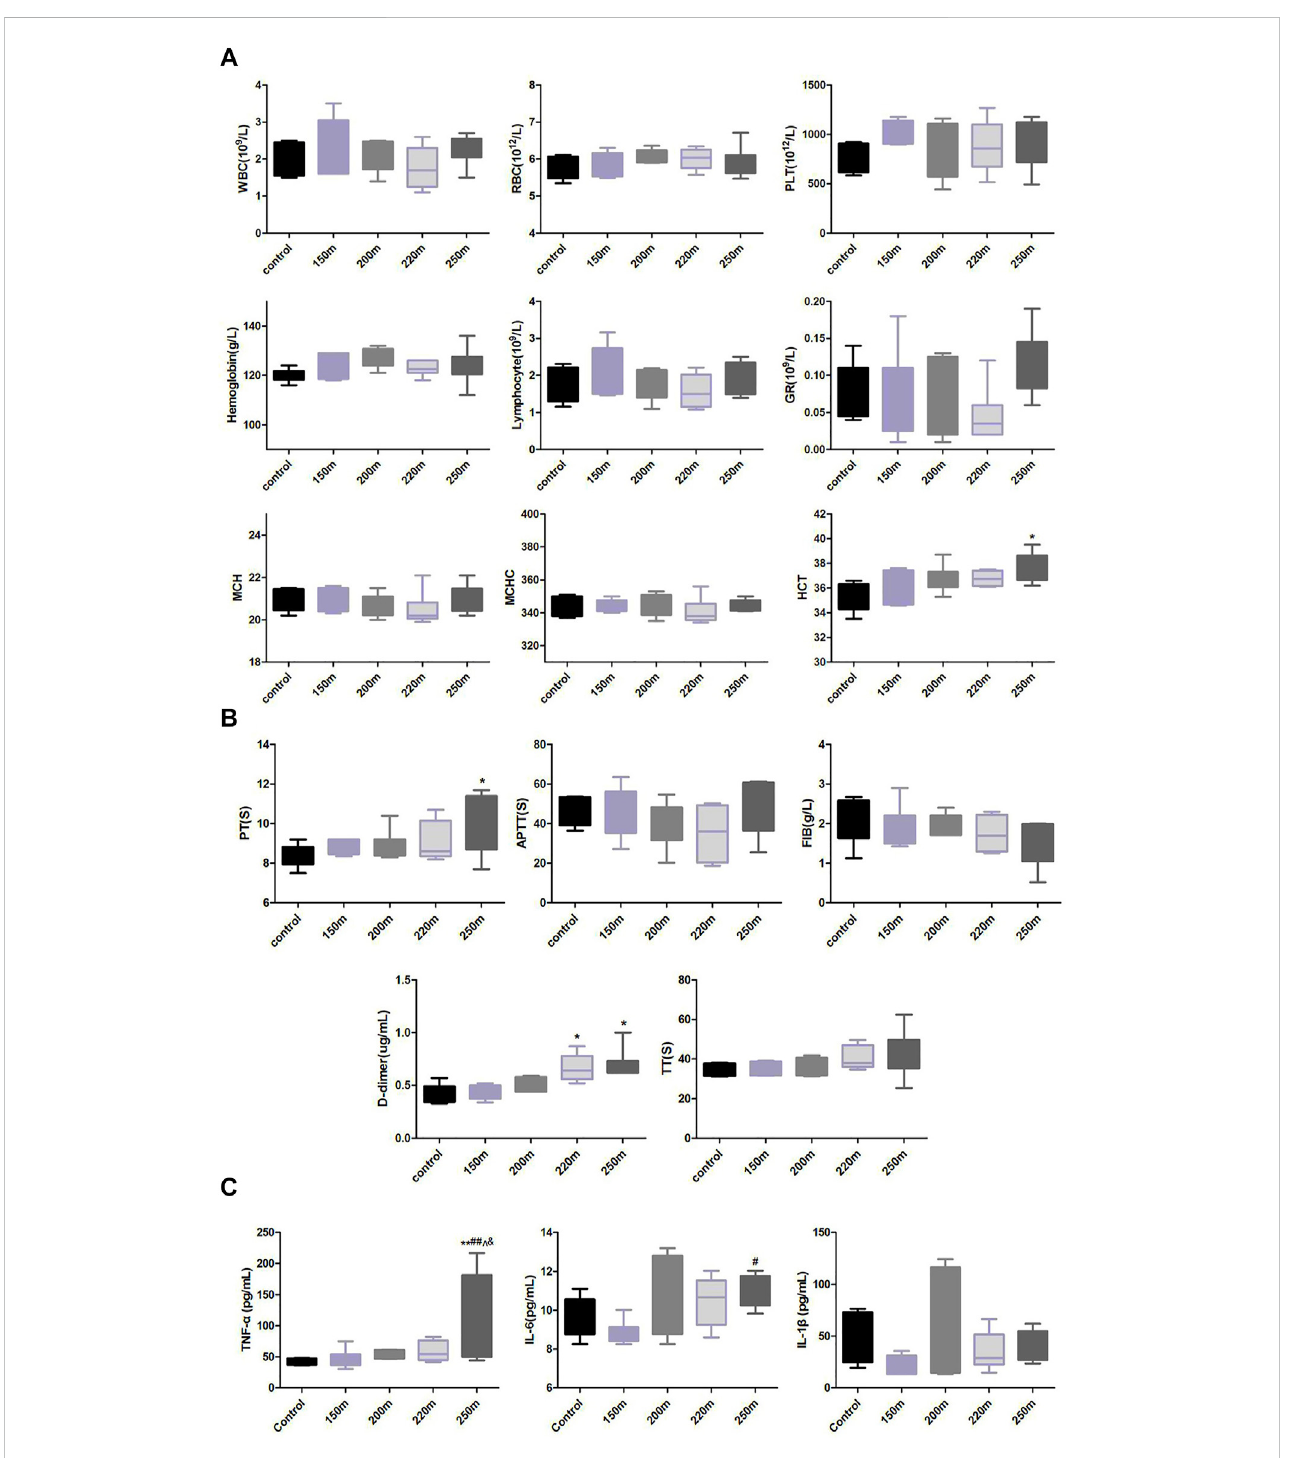
FIGURE 4 Effect of depth of simulated submarine tower escape on peripheral blood cells (A) , coagulation and fi brinolysis indexes (B) , and lung levels of proin fl ammatory cytokines (C) . One-way ANOVA was performed based on the normality of the distribution by Kolmogorov – Smirnov test. Results are the minimum to maximum values ( n = 5 – 8per group). * p < 0.05, ** p < 0.01 compared to the control; ## p < 0.01 compared to 150-m escape; ^ p < 0.05 compared to 200-m escape; & p < 0.05 compared to 220-m